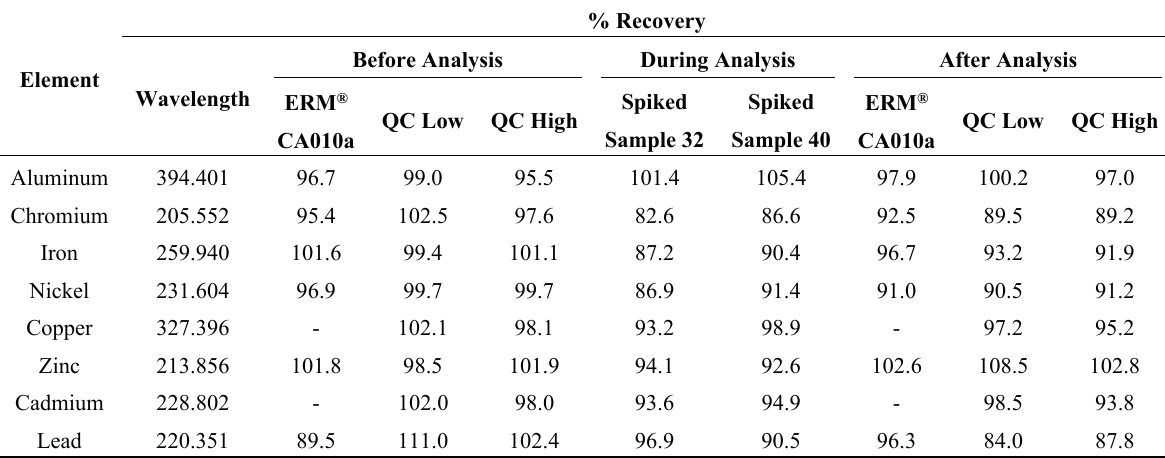
Table 4. Percentage recoveries of the QC standard solutions and ERM ® -CA010a obtained before, during and after